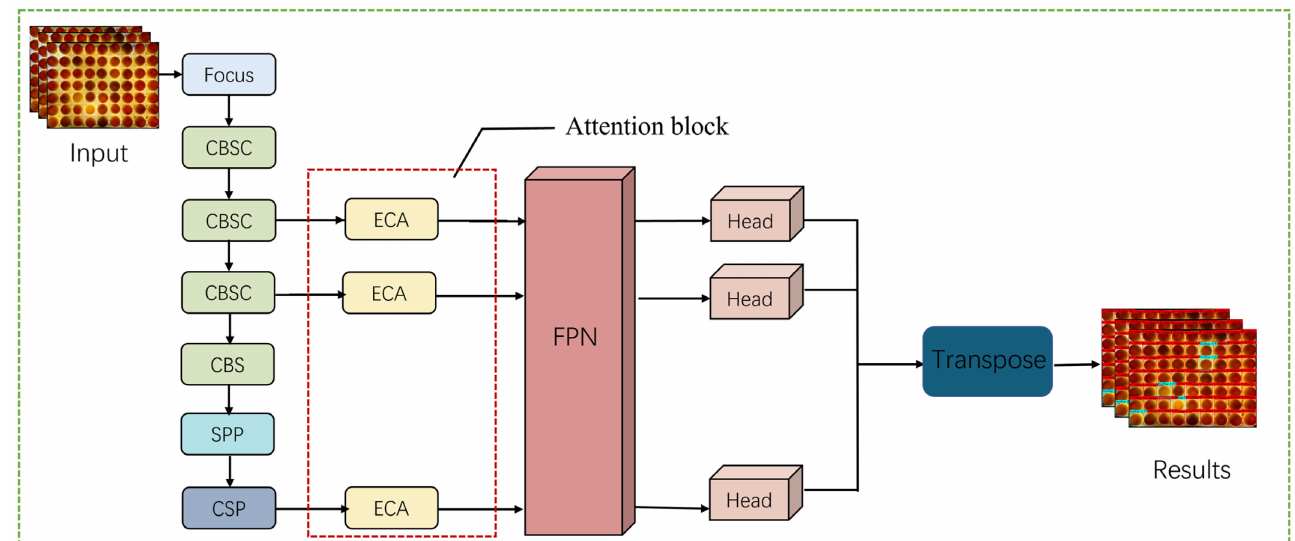
Figure 6. Network structure after adding attention